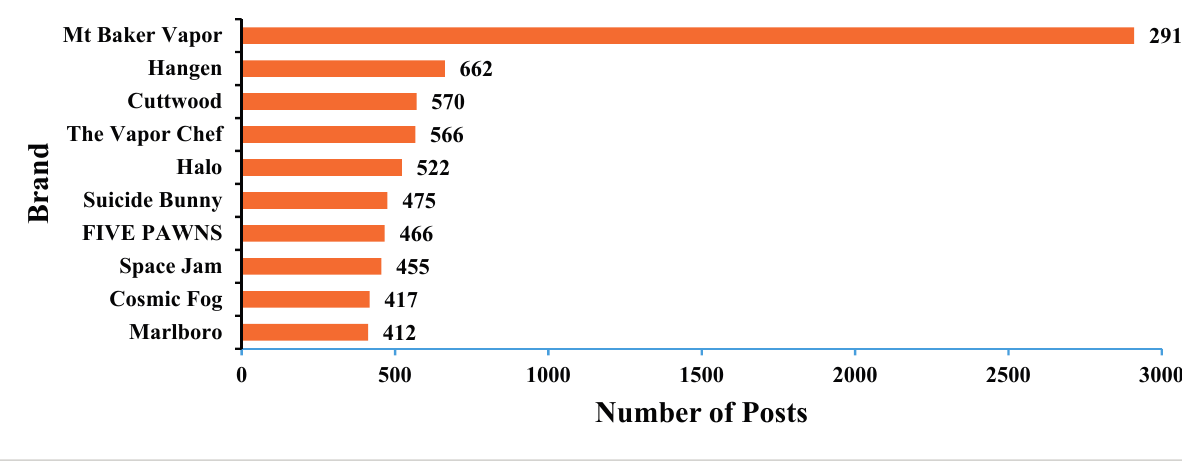
Figure 4. Top-10